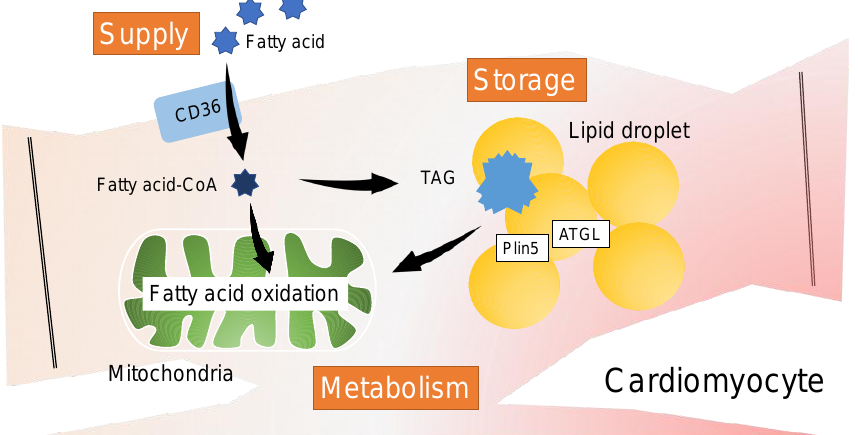
Figure 1. FA dynamics in cardiomyocytes. The supply, storage, and metabolism of the FAs are strictly controlled in healthy hearts. TAG, triacylglycerol; ATGL, adipose triglyceride lipase; Plin5, perilipin 5.